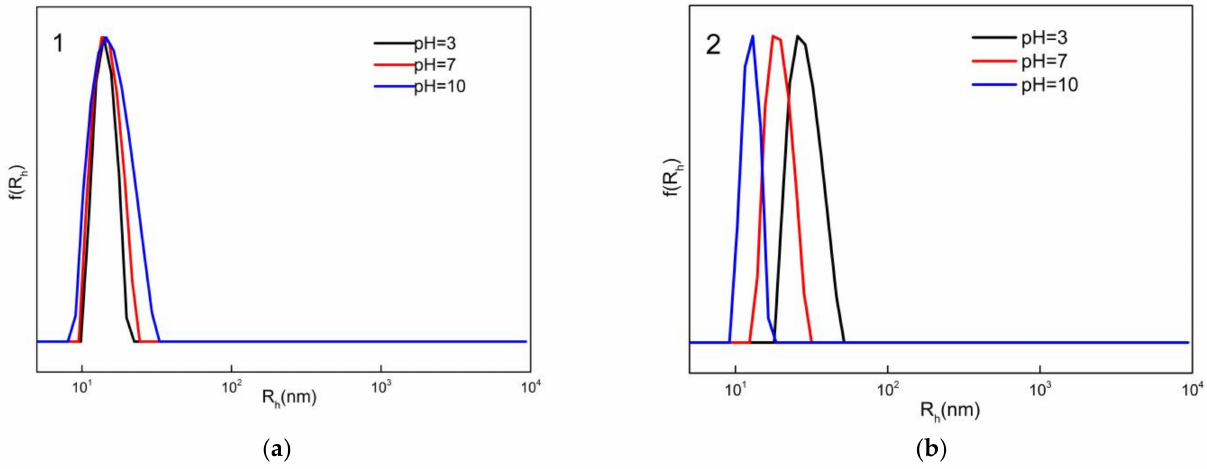
Figure 5. Size distributions from DLS analysis of HC 1 ( a ) and HC 2 ( b ) self-assembly in aqueous media at different pH values. Table 2. DLS results of HCs in aqueous media in varying pH solutions. HC